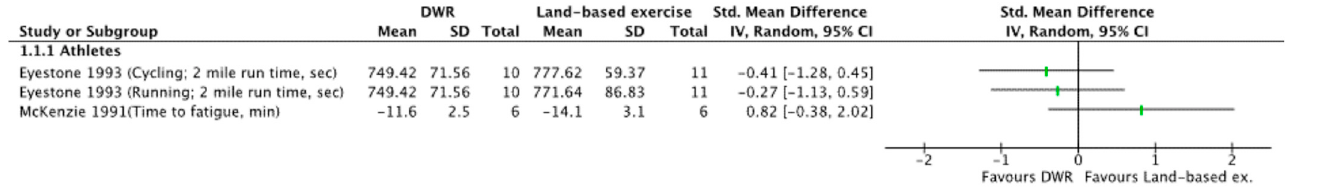
Figure 5. Standardized mean difference (95% CI) for the effect of DWR compared with land trainings on physical function outcomes [26,28].